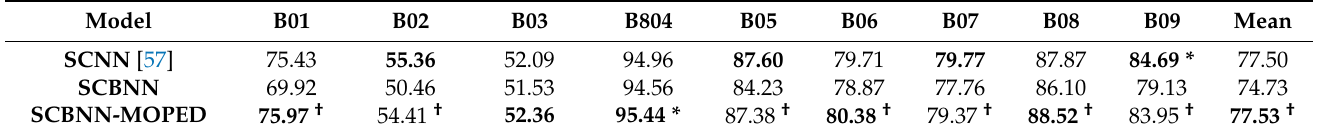
Table 3. Subject-specific classification results (% accuracy) on dataset 2b.